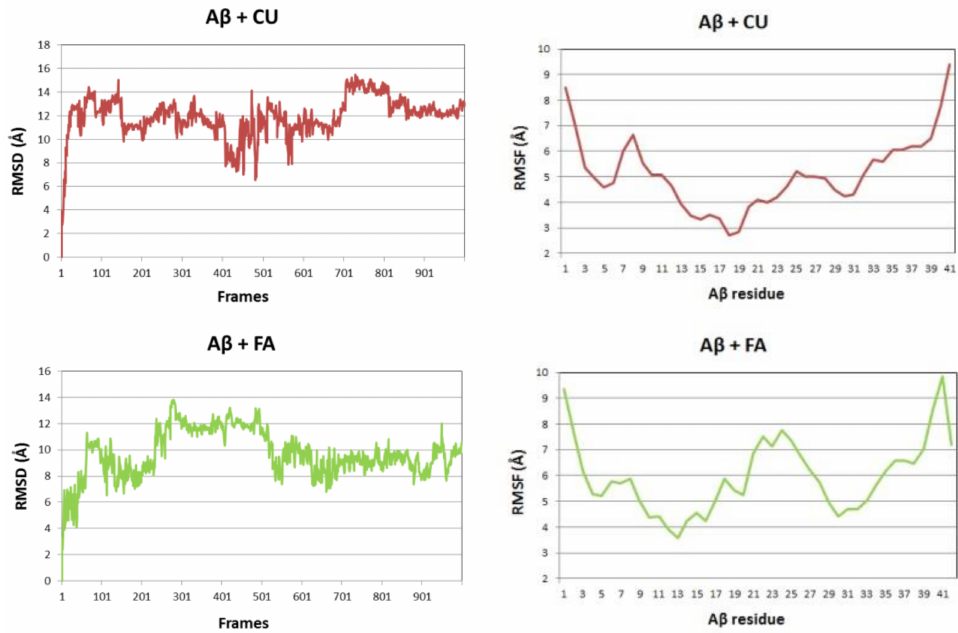
Figure 4. A β backbone RMSDs ( left panels) and RMSFs per residue ( right panels) of the modelled systems: A β peptide (blue), A β peptide and CU (red), A β peptide and FA (green).